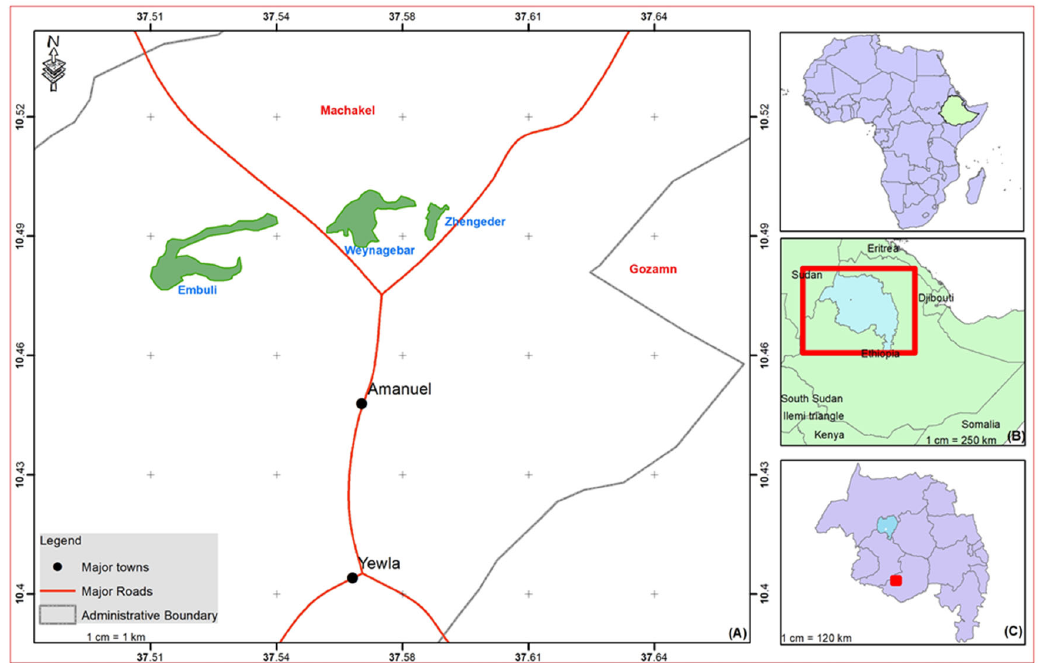
Figure 1. The locations of the three forest study patches in East Gojjam zone, Amhara National Regional State (ANRS) in relation to the map of Ethiopia, ( A ) map of three forest patches, ( B ) map of Ethiopia, ( C ) map of ANRS.